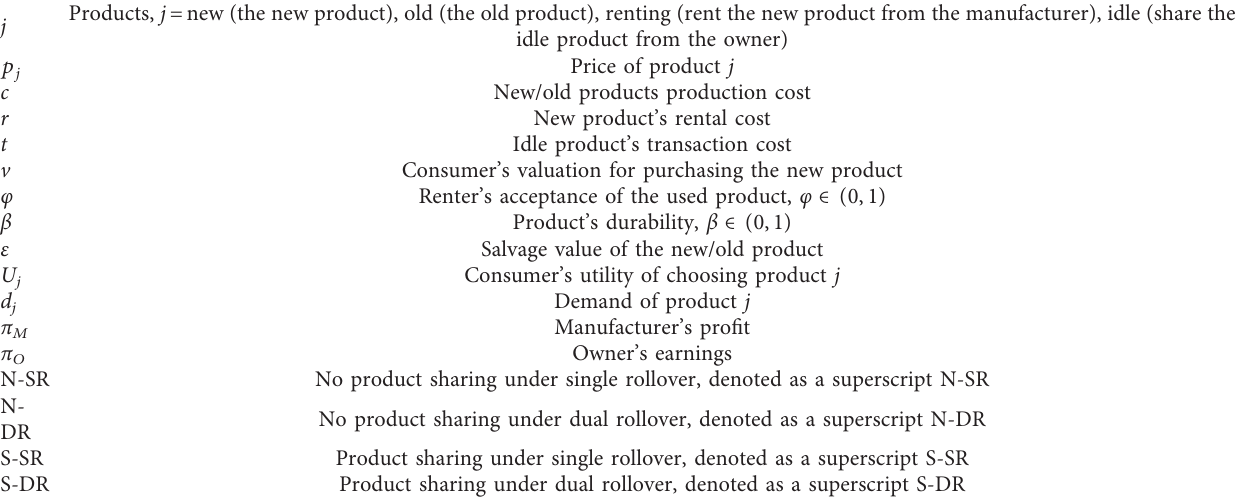
Table 2: Notations and definitions used in the